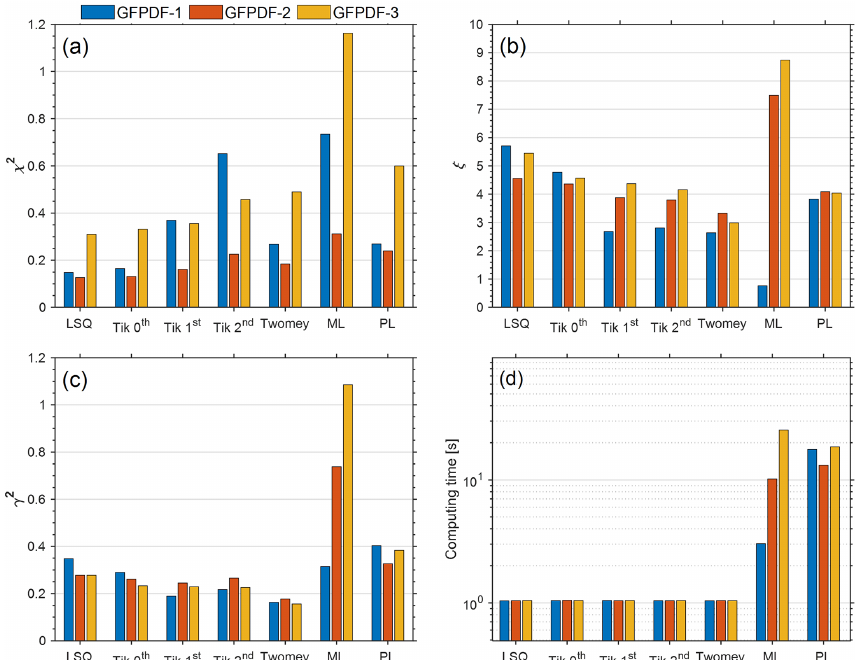
Figure 4. Comparison of reconstruction residual ( χ 2 ) (a) , the smoothness ( ξ ) (b) , the GF-PDF error ( γ 2 ) (c) , and the computing time (d) of GF-PDFs inverted using different inversion methods. Colors correspond to the pre-defined GF-PDFs with one mode (blue), two modes (orange), and three modes (yellow). The results are averages based on inversions of 500 sets of synthetic HFIMS data for each of the three pre-defined